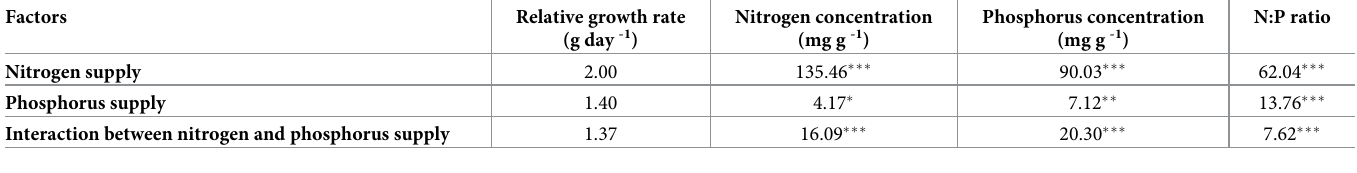
Table 4. Effects ( F value) of nitrogen and phosphorus supply and their interaction on the relative growth rate of A . philoxeroides , nitrogen and phosphorus concen- trations, N: P ratio in its leaf.